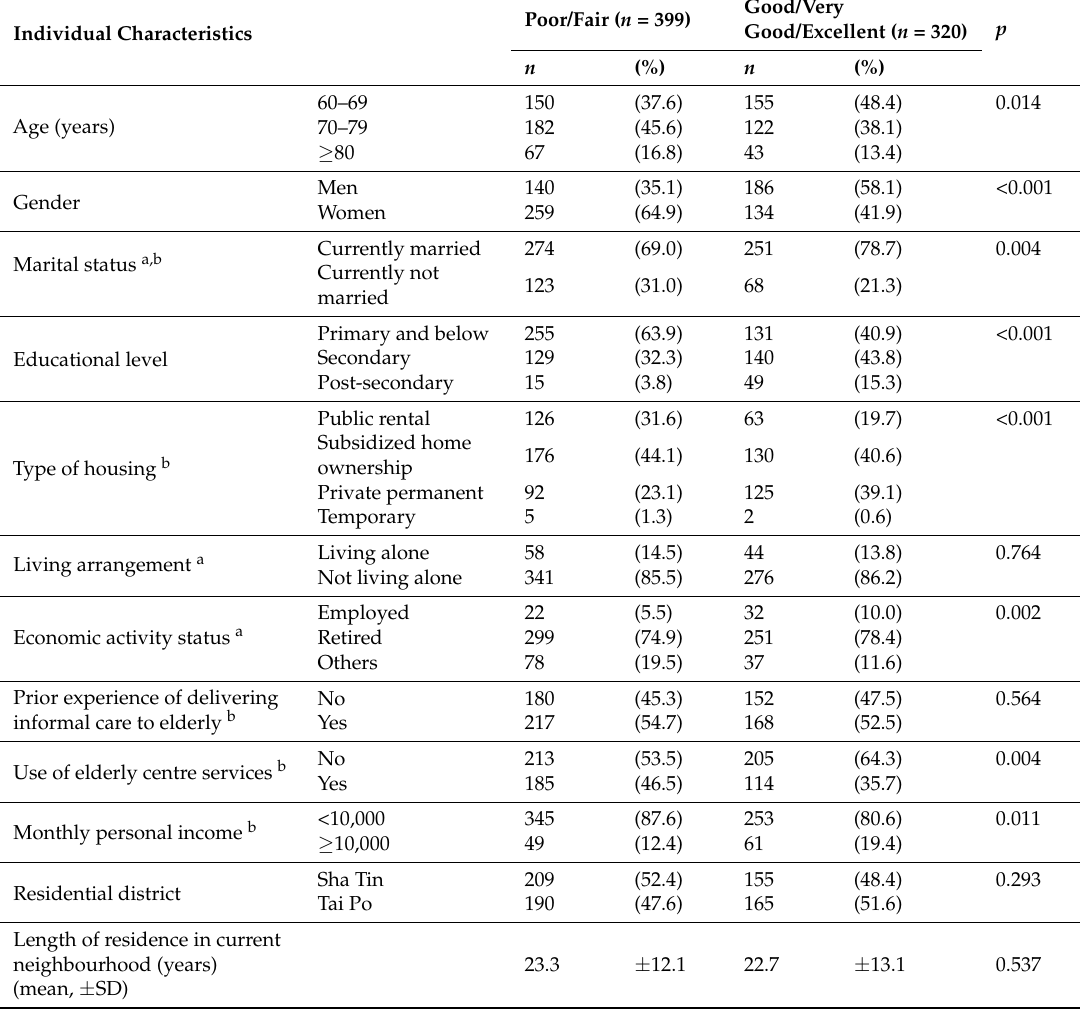
Table 1. Bivariate associations between self-rated health and independent